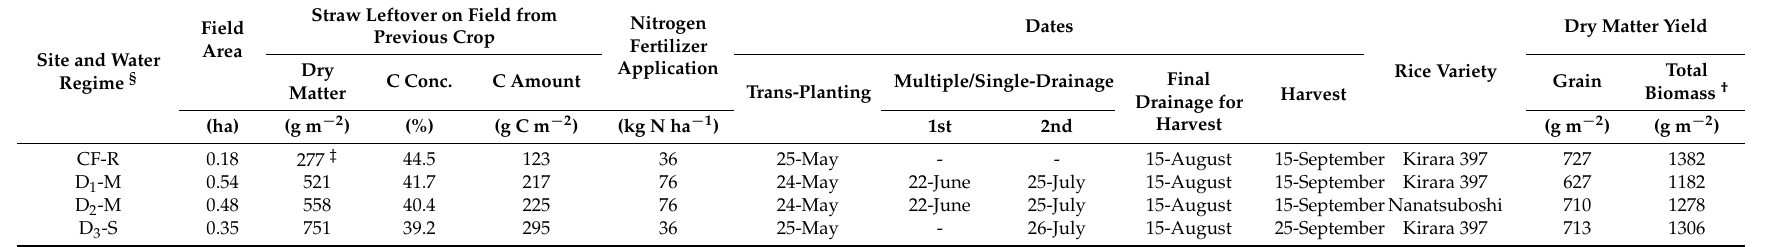
Table 3. Summary of management and dry matter yield of the investigated paddy